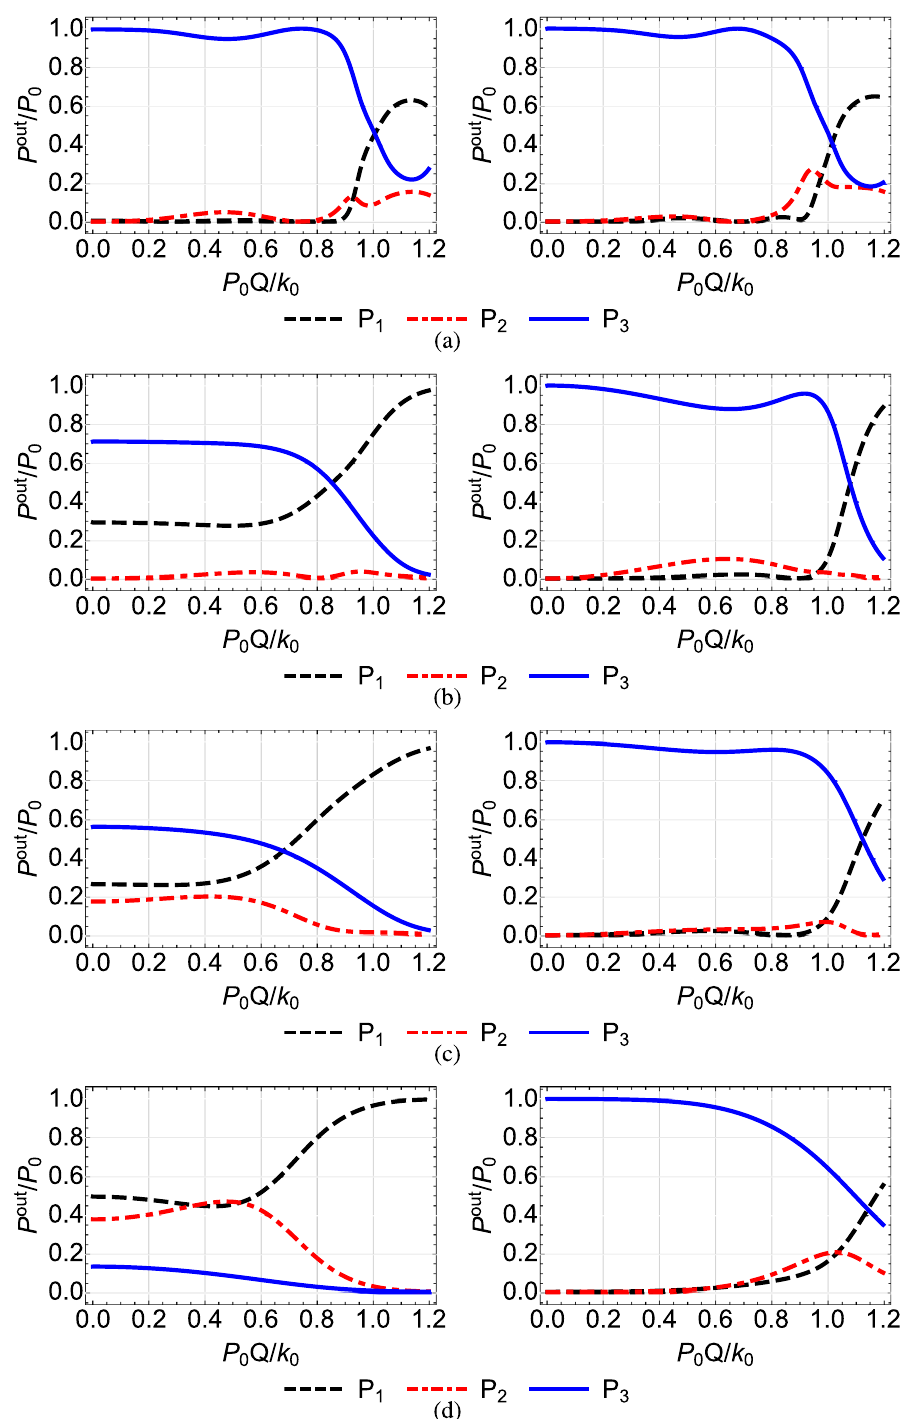
out P P i ( Z )/ P 0 0 at each waveguide as a function of the normalized i / = Q , Q Q , for the Gaussian (left column) and modified shortcut 0, Q 3 2 = = =